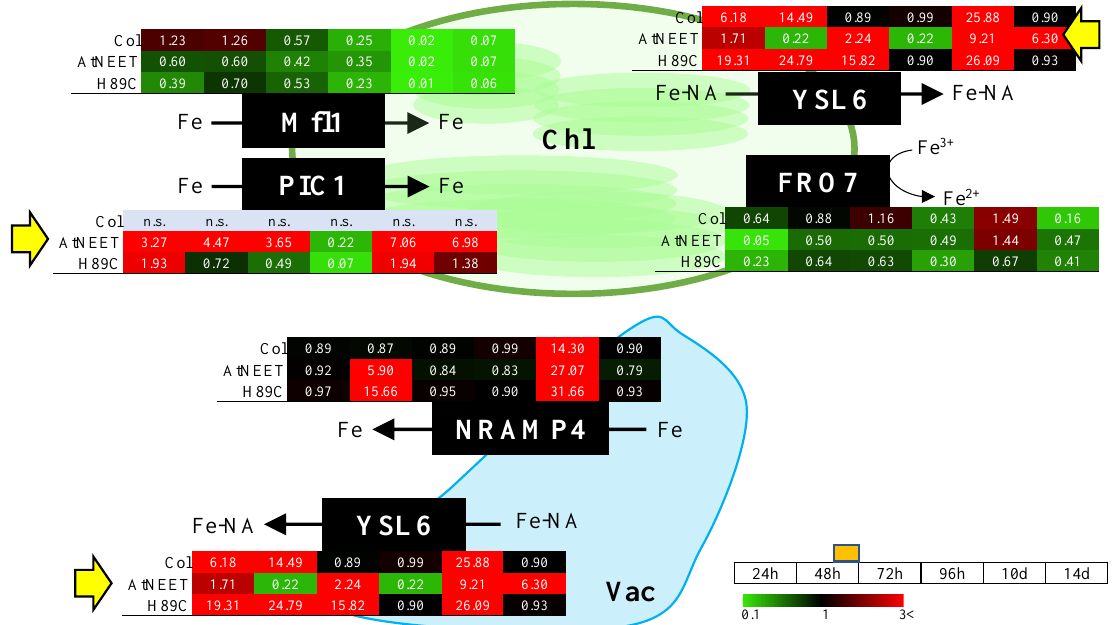
Figure 6. Changes in protein expression levels associated with iron/metal transport during the course of the experiment. Pathway and heat maps for the expression pattern of different proteins with a significant change in expression (in at least one time point, compared to time 0 h within each genotype) associated with the transport of iron and other metals into and out of the chloroplast and vacuole are shown. Yellow arrows highlight proteins of interest at the different points. All experiments were repeated at least three times with similar results. Abbreviations used: Chl, chloroplast; FRO7, Ferric Reduction Oxidase 7; Mfl1, Mitoferrin-like 1; NRAMP4, Natural Resistance Associated Macrophage Protein 4; n.s., not significant; PIC1, Permease In Chloroplasts 1; Vac, vacuole; YSL6, Yellow Stripe Like 6.